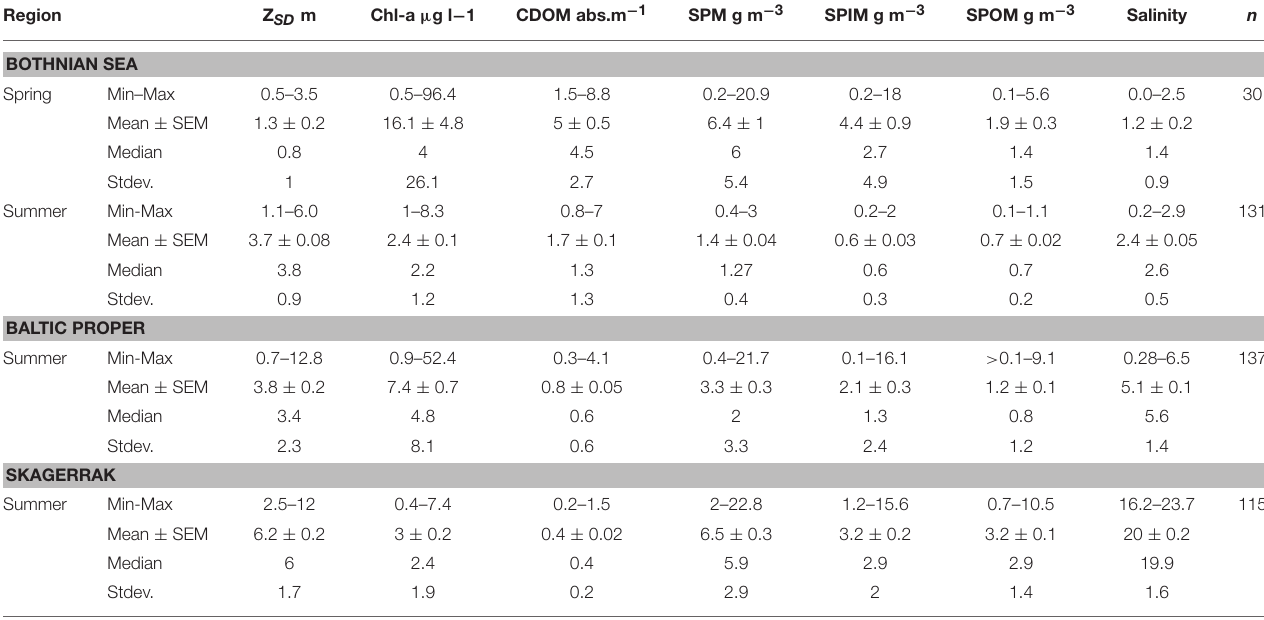
The table shows the ranges, mean, standard error of the mean (SEM), median and standard deviation (Stdev.) for Secchi depth (Z SD ), Chlorophyll-a concentration (Chl-a), colored dissolved organic matter (CDOM), suspended particulate matter (SPM), inorganic suspended particulate matter (SPIM), organic suspended particulate matter (SPOM), Salinity and Number of observations (n).